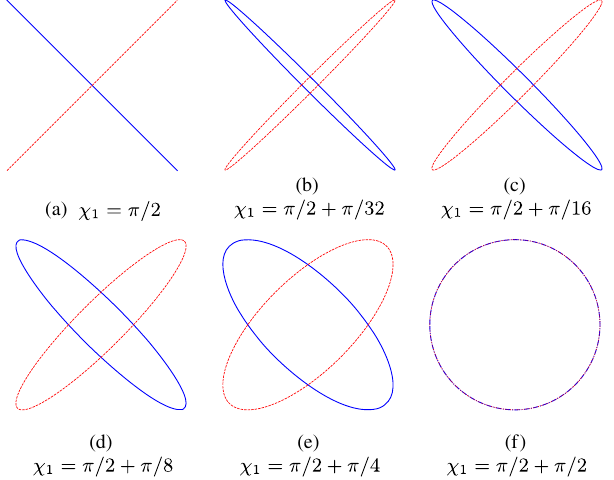
FIG. 12. Hodograph of elliptical polarization state (blue line) and velocity in a helical undulator (red line) depending on the phase χ 1 .